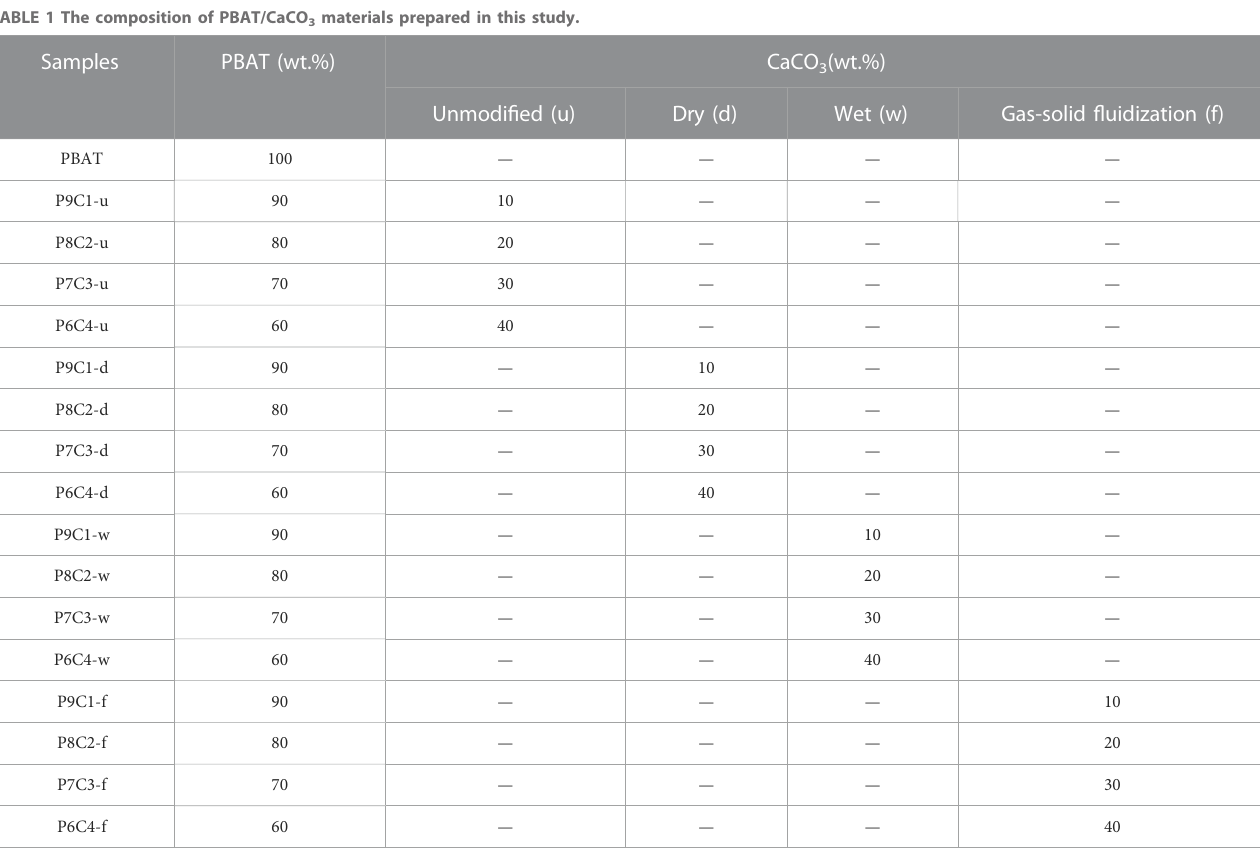
TABLE 1 The composition of PBAT/CaCO 3 materials prepared in this study.